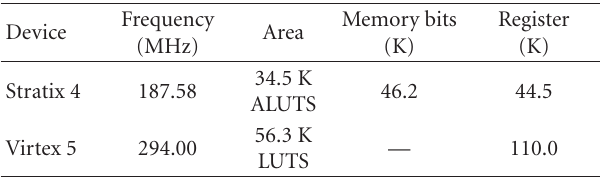
Table 3: DMPDS synthesis